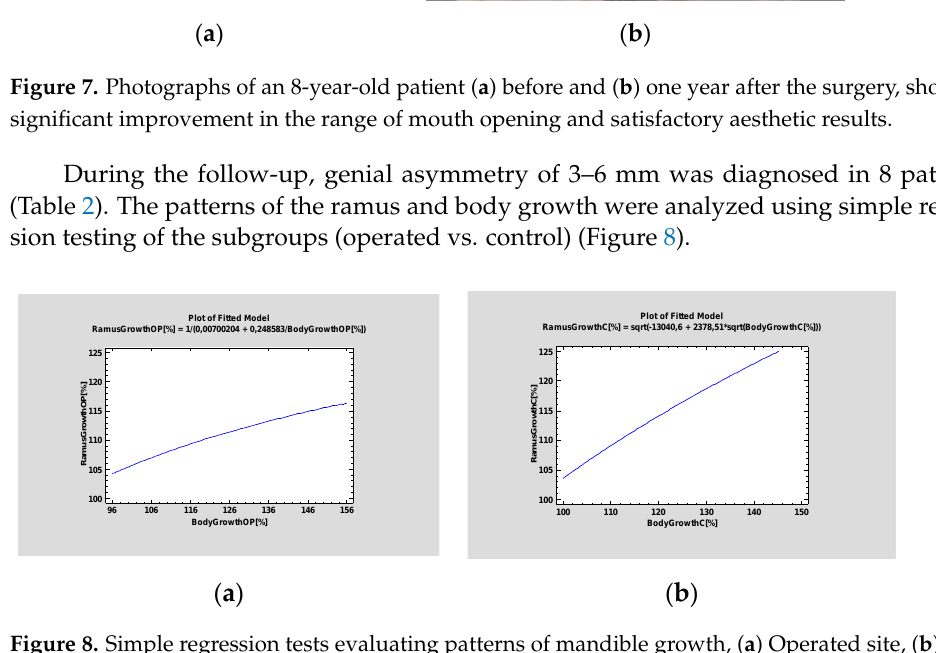
Figure 8. Simple regression tests evaluating patterns of mandible growth, ( a ) Operated site, ( b ) Control site. It can be observed that the operated side exhibited decreased capacity for growth over time when compared with the healthy side. Statistical significance was established at p < 0.005.